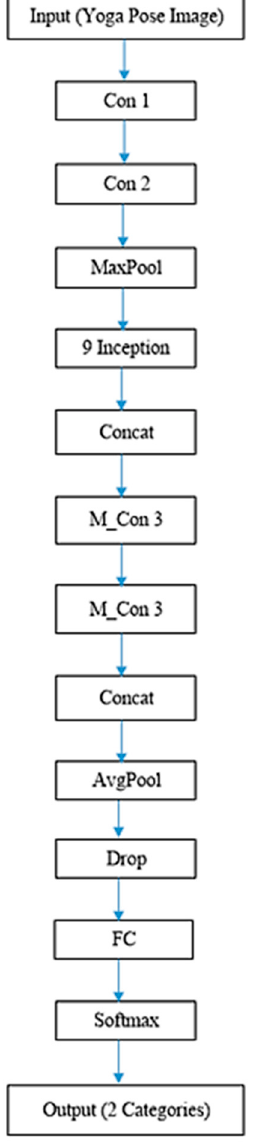
Figure 6. Block representation of the proposed Y_PN-MSSD model.